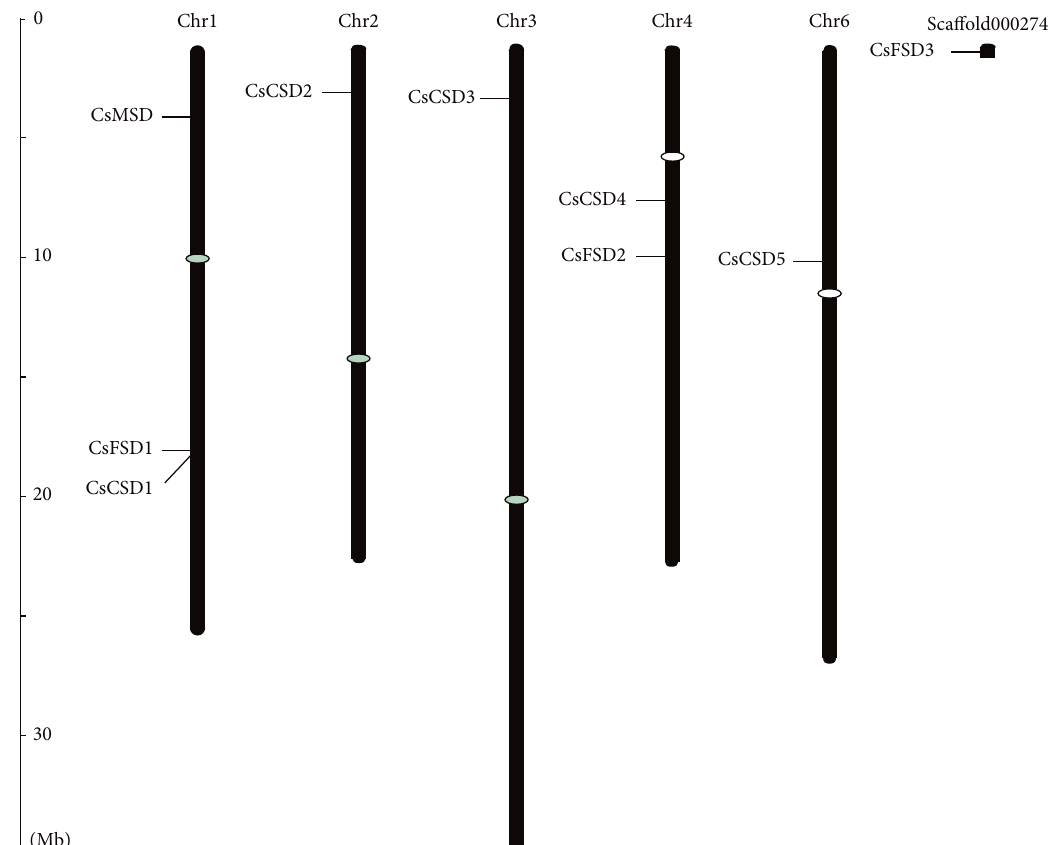
Figure 3: Chromosomal locations of 9 CsSOD genes on chromosomes of cucumber. The chromosome numbers are indicated at the top of chromosomes, and the size of chromosome is represented with a vertical scale.